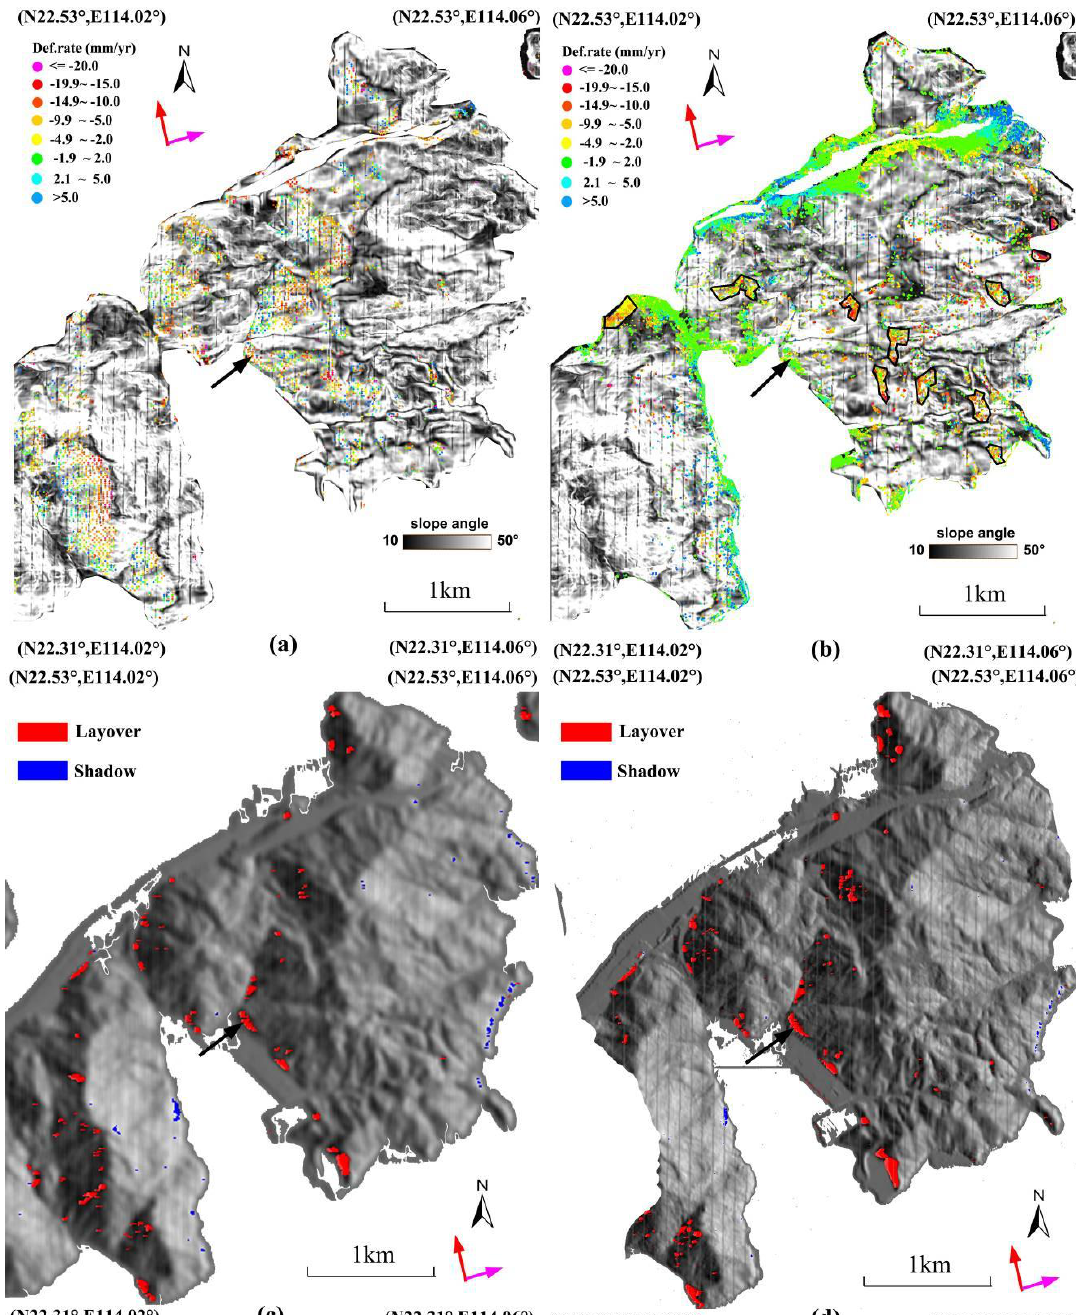
Figure 9. Performance evaluation of ALOS PALSAR and TerraSAR for the unstable slope monitoring, black arrows indicate the occurrence of CPs on layovers in this study; ( a ) PALSAR-derived slope-projected data; and ( b ) TerraSAR-derived slope-projected data overlapped on the slope map of Disneyland region (suspected unstable slopes marked by black polygons); ( c ) and ( d ) are visibility maps of PALSAR, TerraSAR indicating layovers and shadows; ( e ) high resolution optical imagery from Google Earth (GE) shows the vegetation coverage and exposed